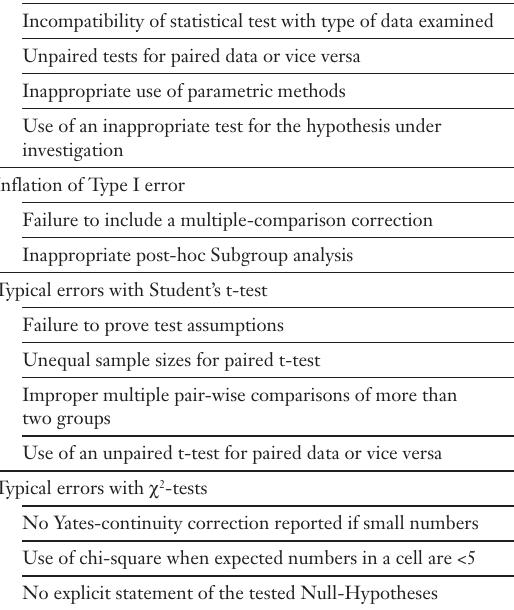
Statistical errors and deficiencies related to data analysis.